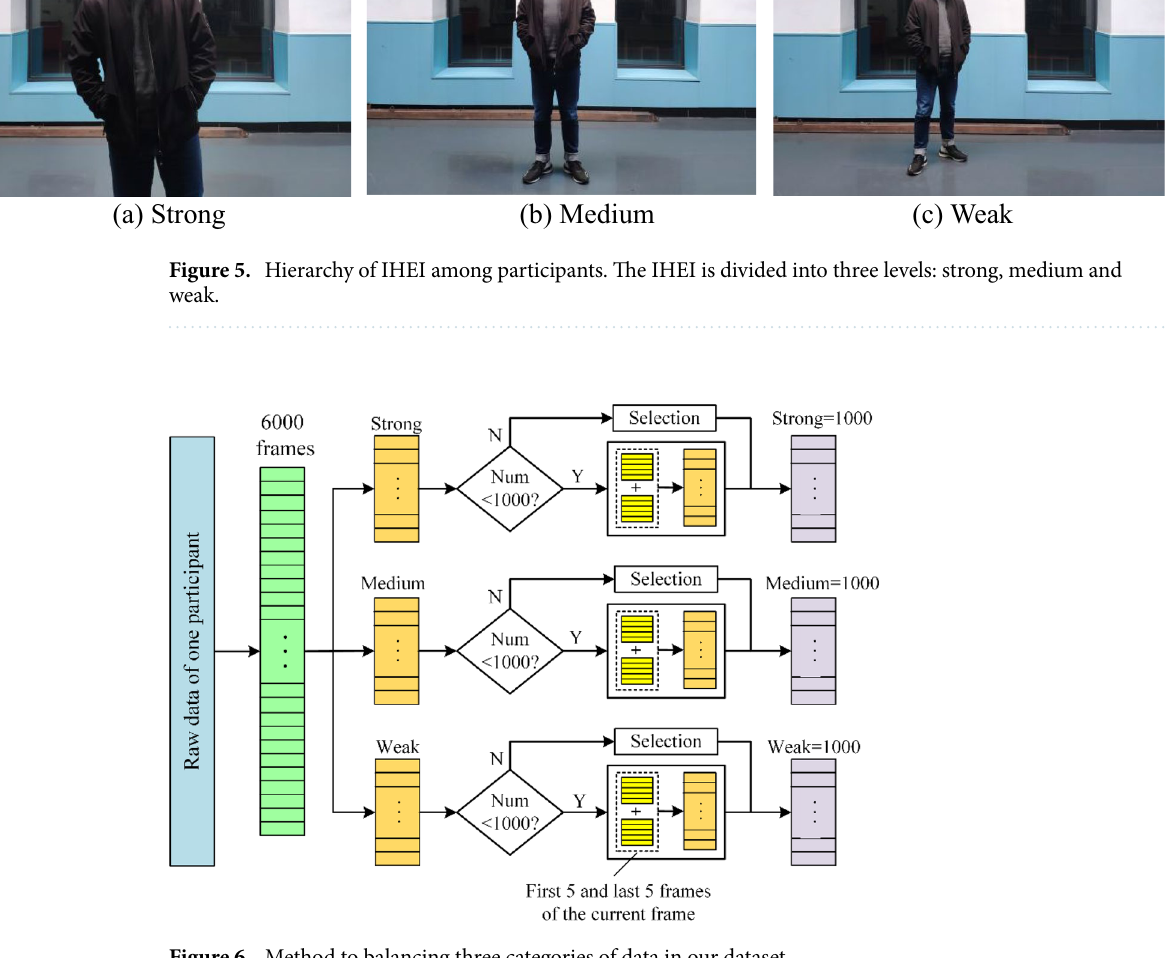
Figure 6. Method to balancing three categories of data in our